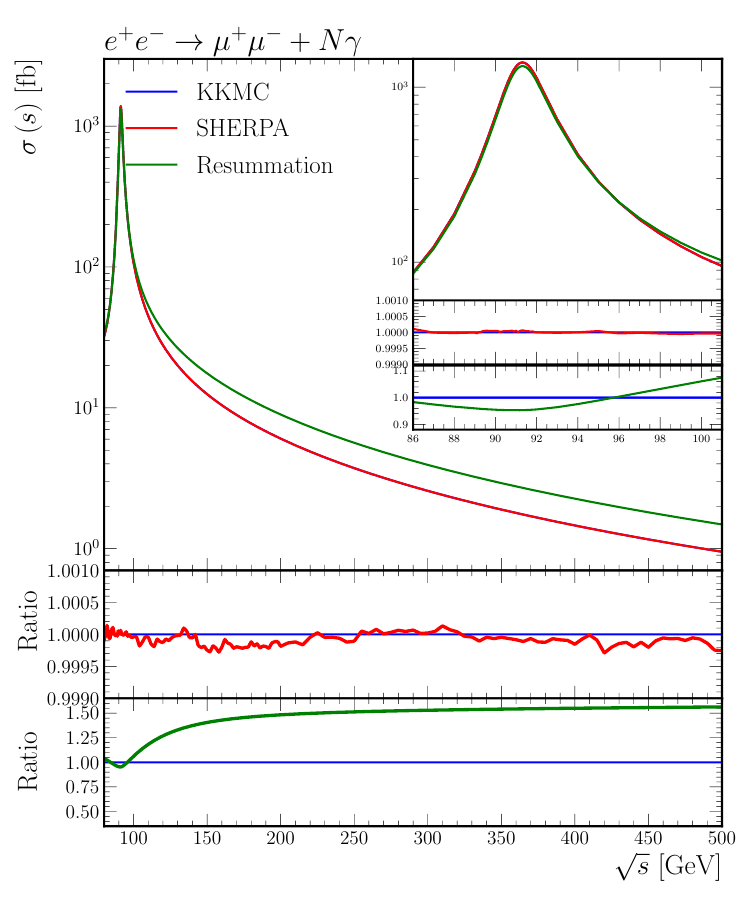
Figure 1: Total cross-section for e + e − → µ + µ − for 80GeV to 500GeV including (cid:0) α 3 (cid:1) L 3 ISR + FSR up to . In the first subplot we show the deviation from the K O